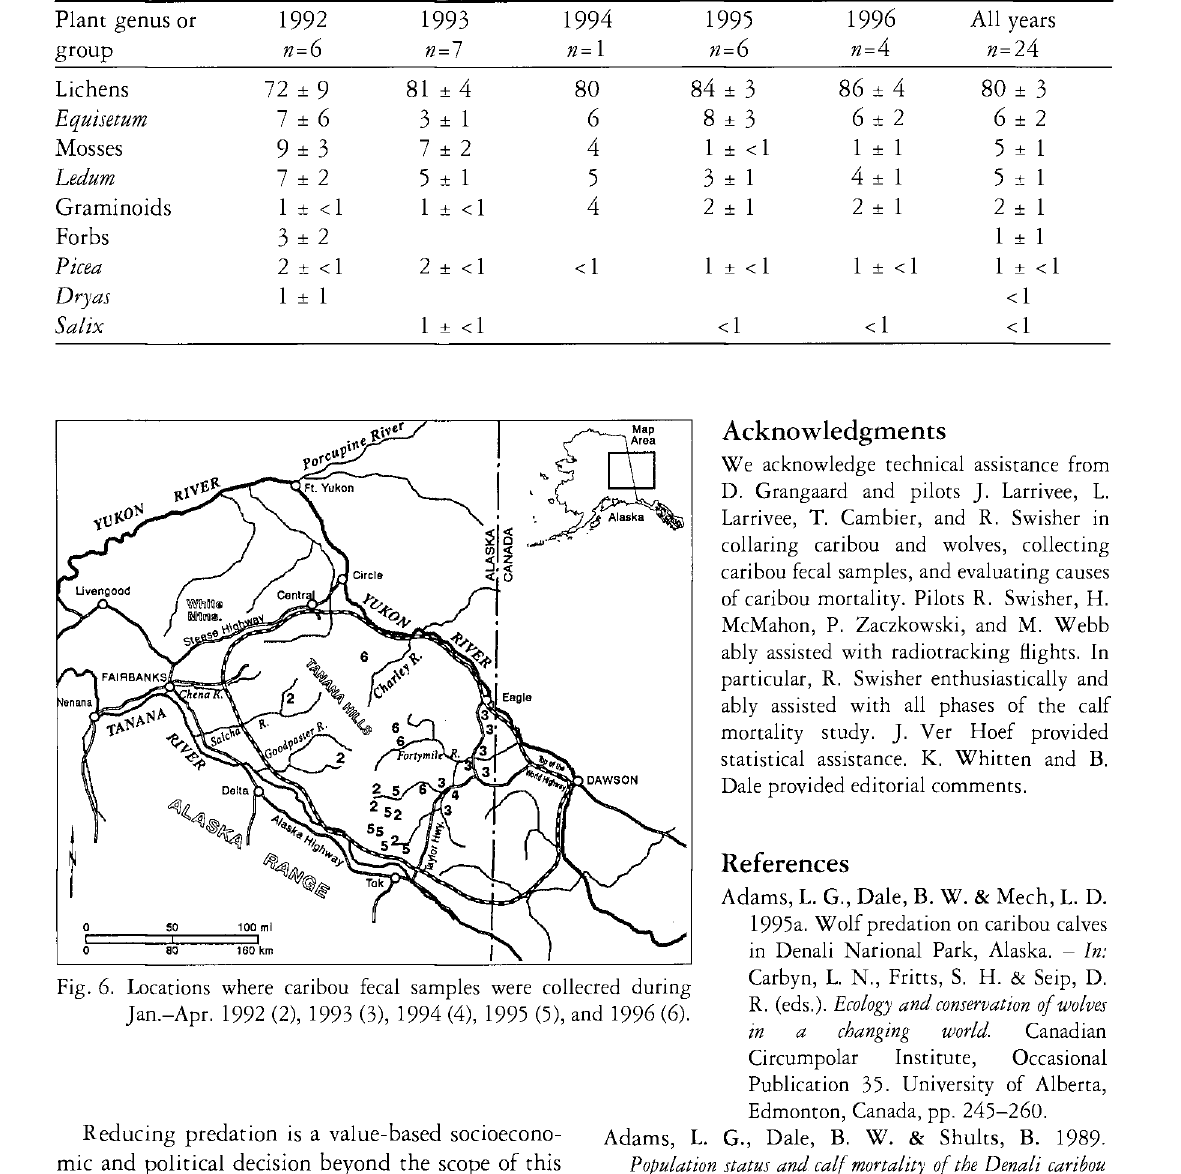
Fig. 6. Locations where caribou fecal samples were collecred during Jan.-Apr. 1992 (2), 1993 (3), 1994 (4), 1995 (5), and 1996